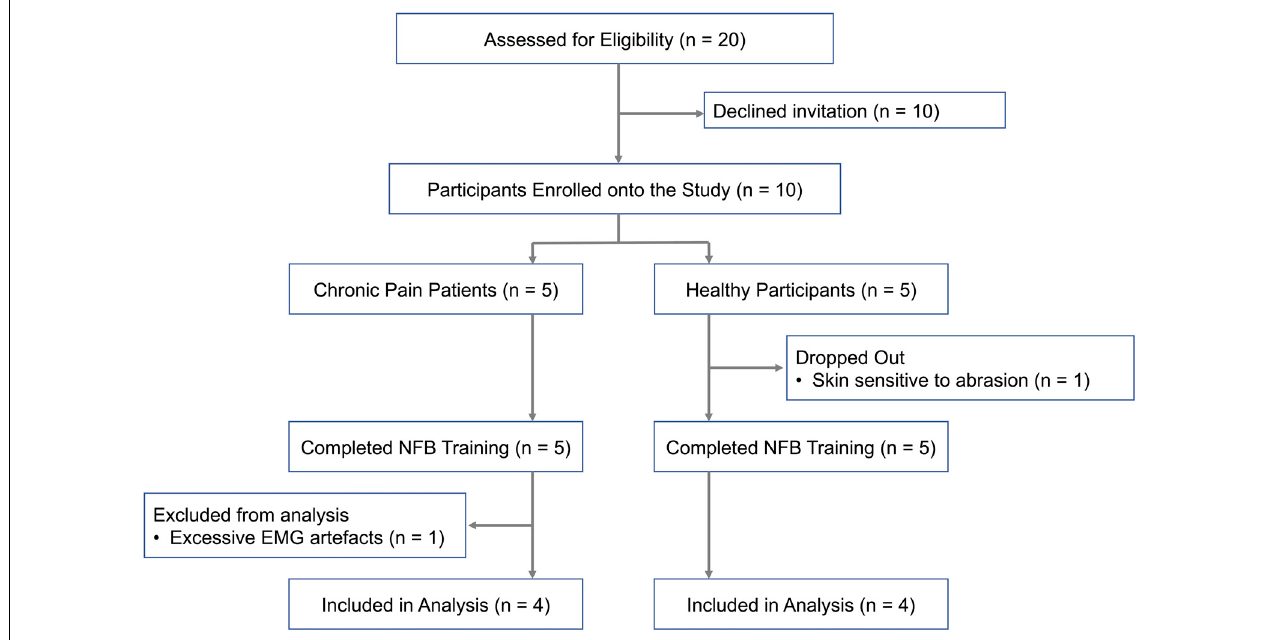
FIGURE 2 | Flow diagram of participant recruitment onto each stage of the